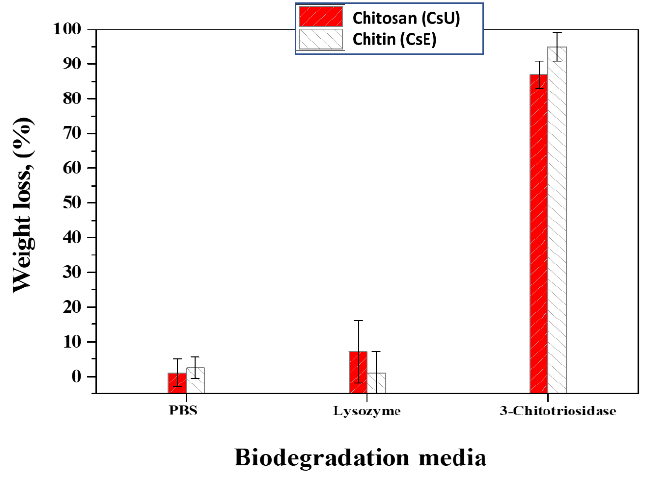
Figure 10. Biodegradation of CsU1 (L09306) based stabilized membranes and its derivate chitin (CsE) based membranes in different media for a period of three weeks.